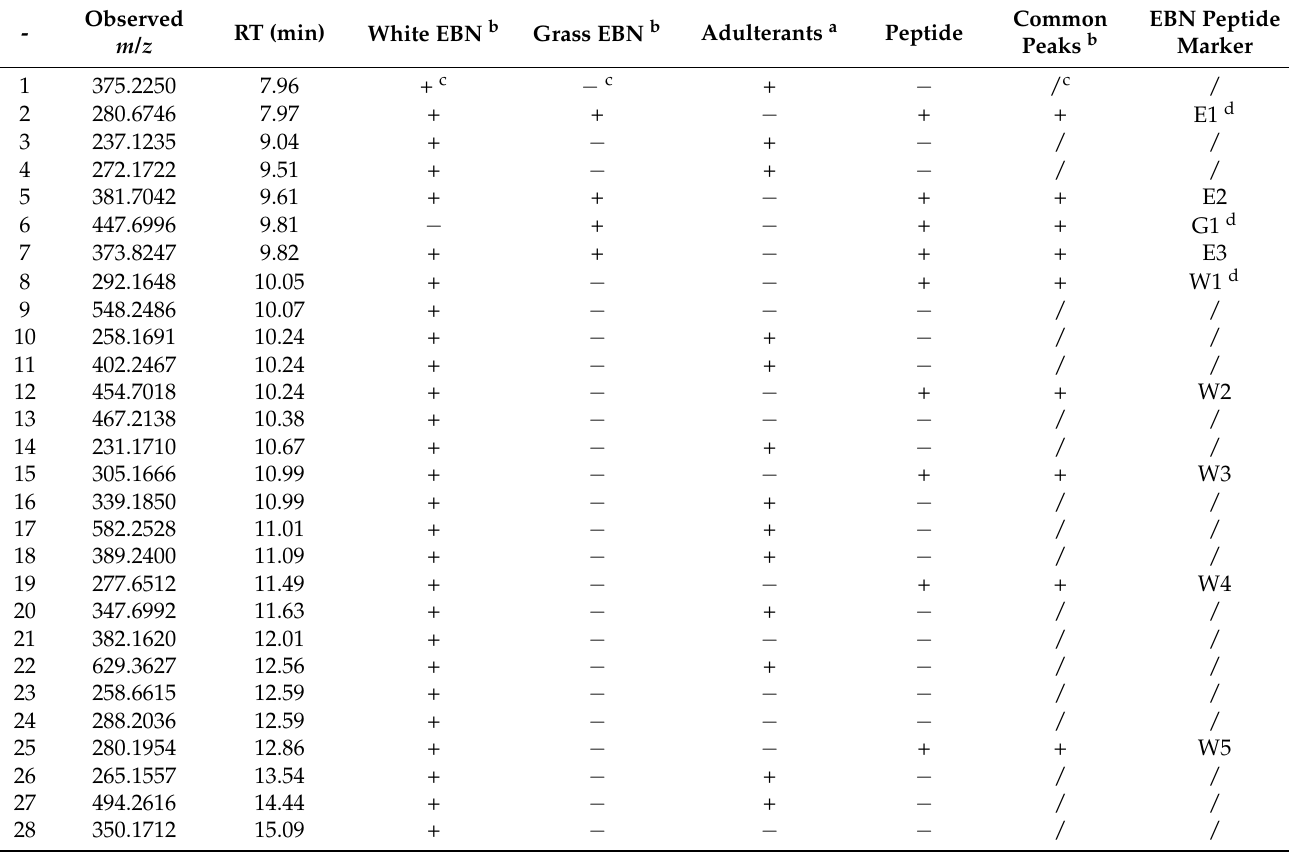
Table 1. Selection of peptide markers of EBN based on retention time, mass-to-charge ratio and